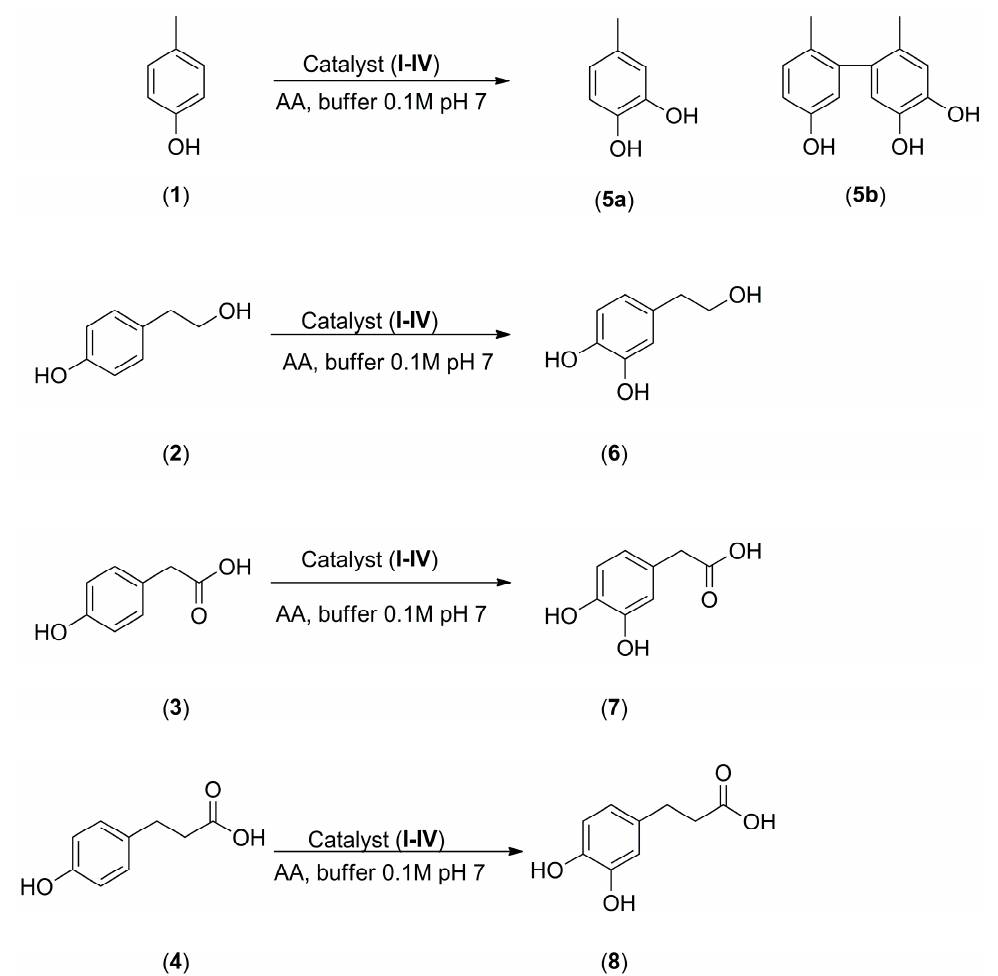
Figure 2. Representative particle diameter distributions of OL nanocapsules and Catalyst I – IV . Scheme 2. Oxidation of phenols 1 – 4 with catalysts I – IV